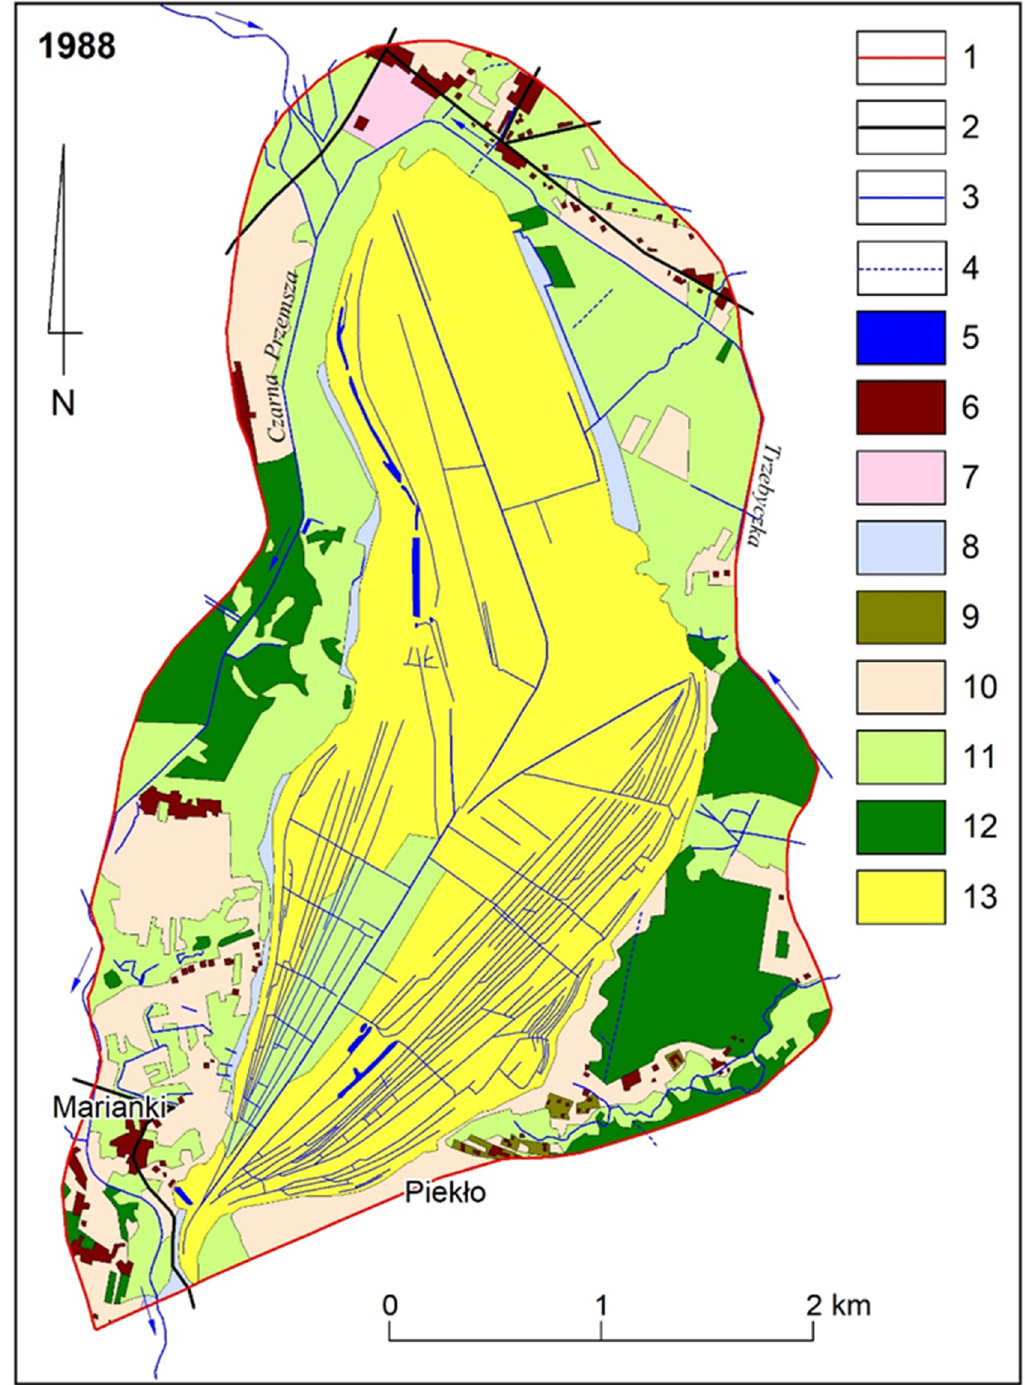
Figure 4. Changes in land use in the area of Ku´znica War˛e˙zy´nska for the year 1988: 1—border of Figure 4 . Changes in land use in the area of Ku ź nica War ęż y ń ska for the year 1988: 1—border of the